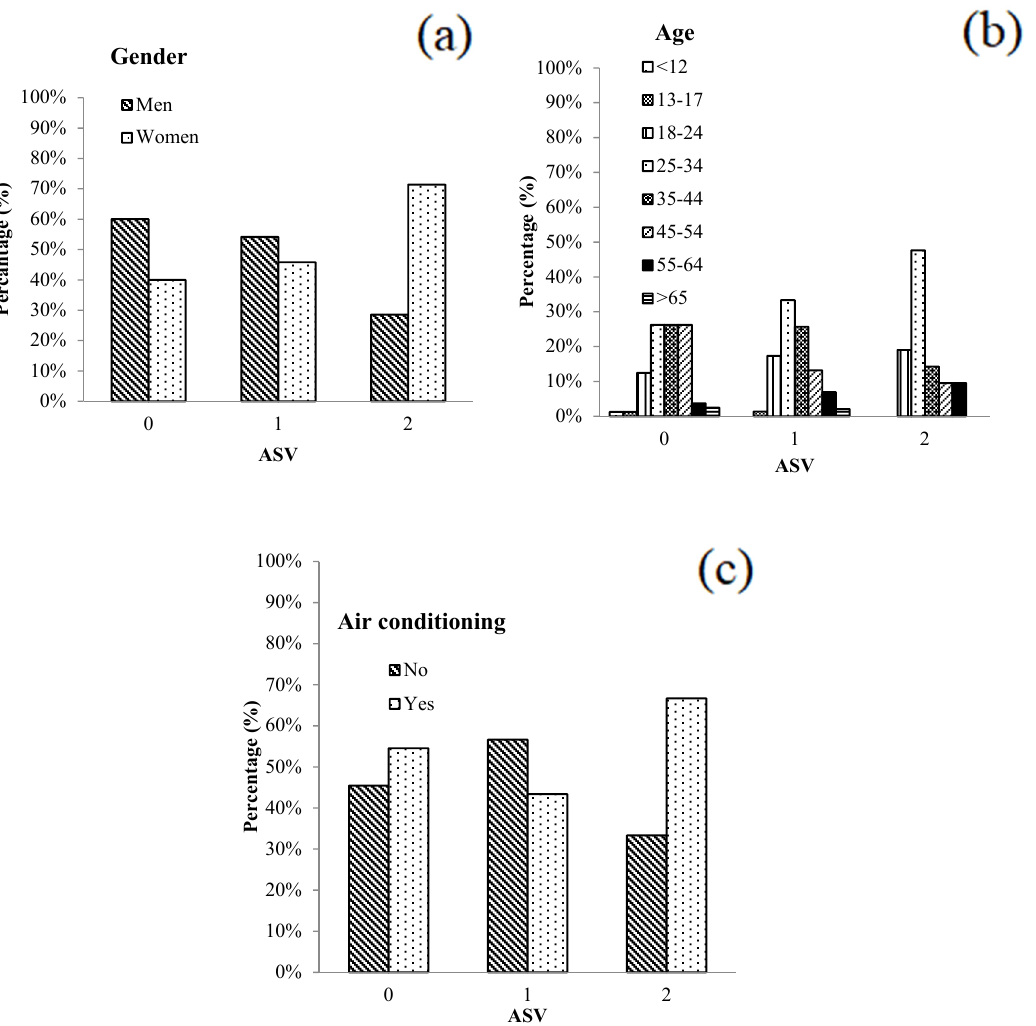
Figure 9. Personal parameters per class of Actual Sensation Vote ( ASV ): ( a ) persons’ gender; ( b ) persons’ age; ( c ) previous stay in air corditioned place.